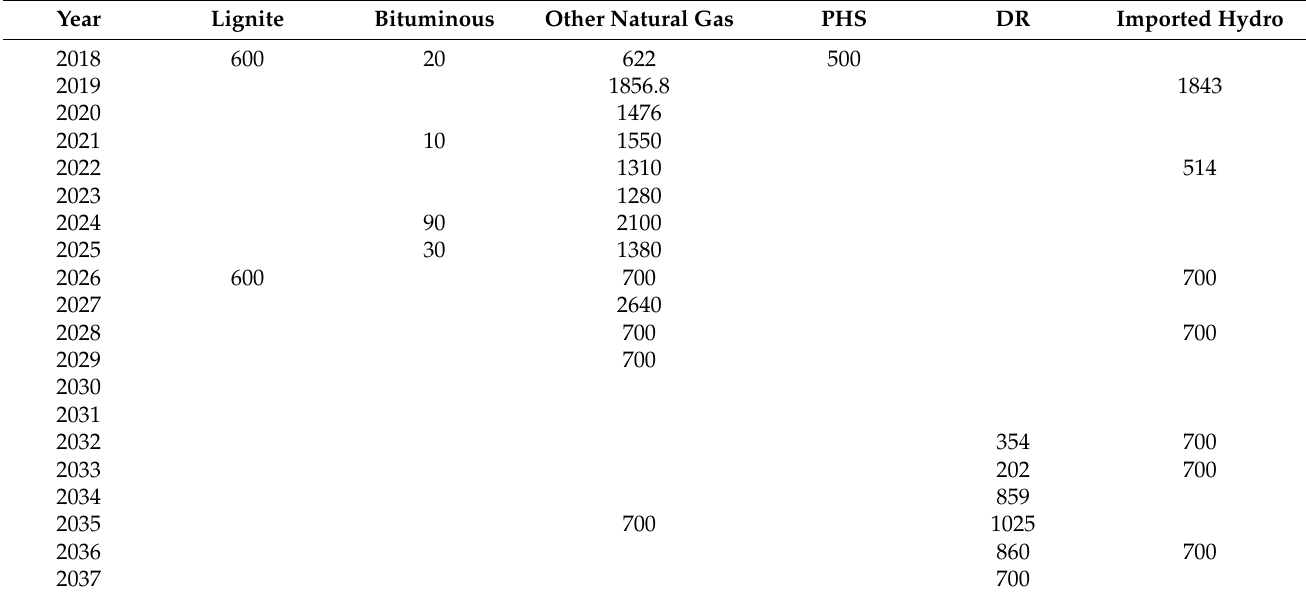
Table A4. Committed conventional generation units (MW).